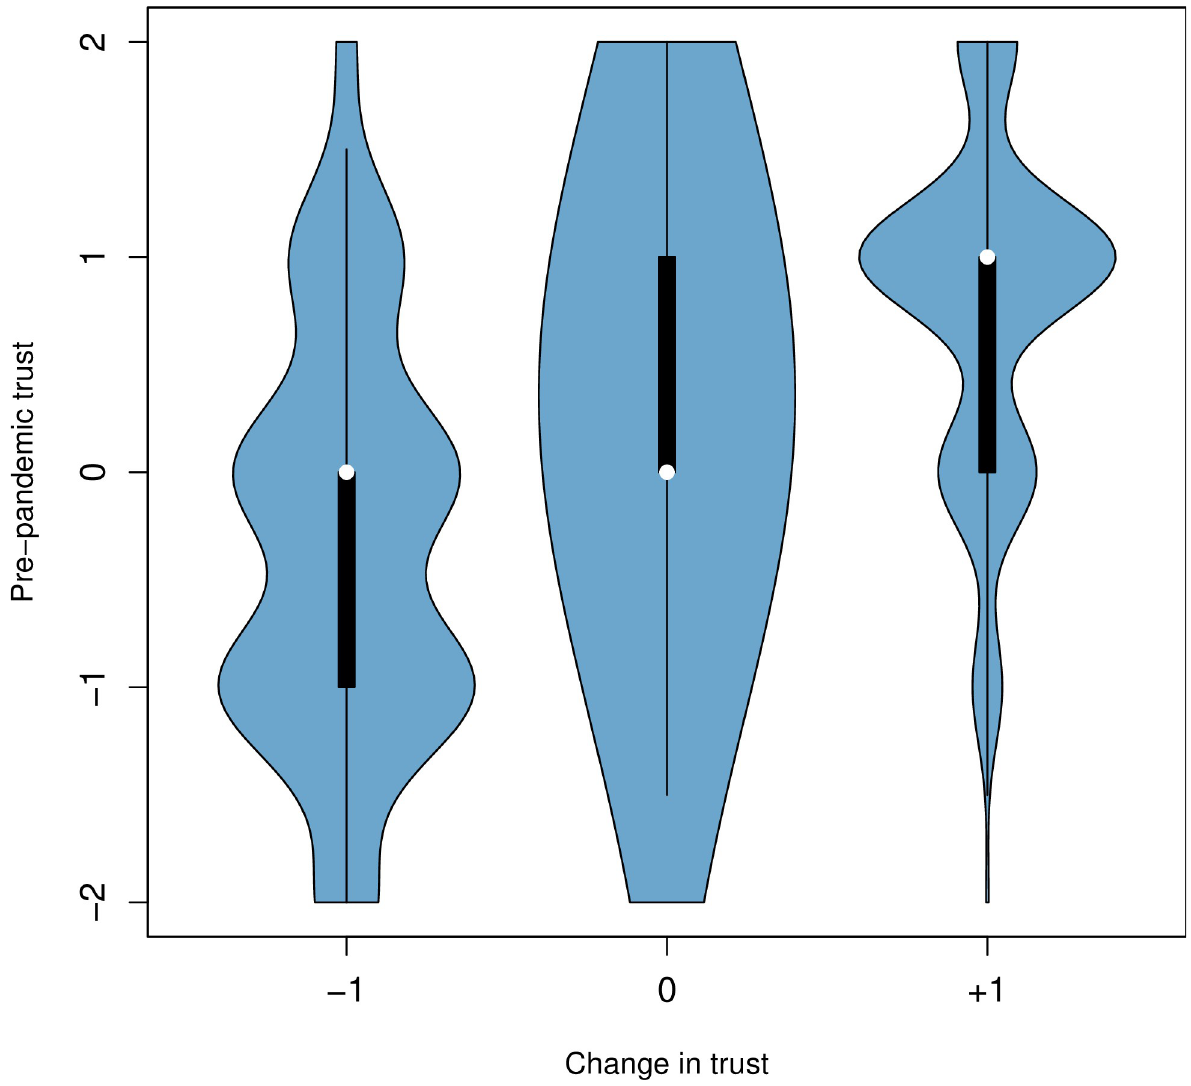
Fig 4. Violin plot of the relationship between change in trust in scientists and self-reported pre-pandemic trust levels (N = 2039).